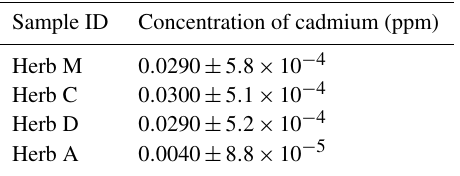
Table 1. Determination of concentration of cadmium in herb sam- ples by using ICP–OES.